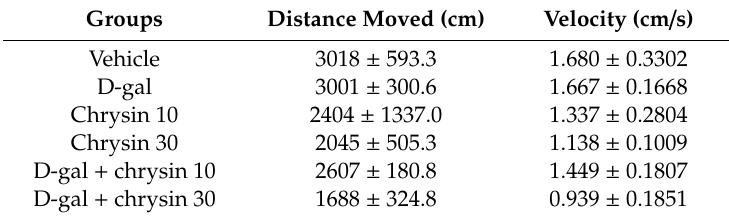
Table 1. Distance moved and velocity (mean ± SEM) in the novel object location (NOL) test after